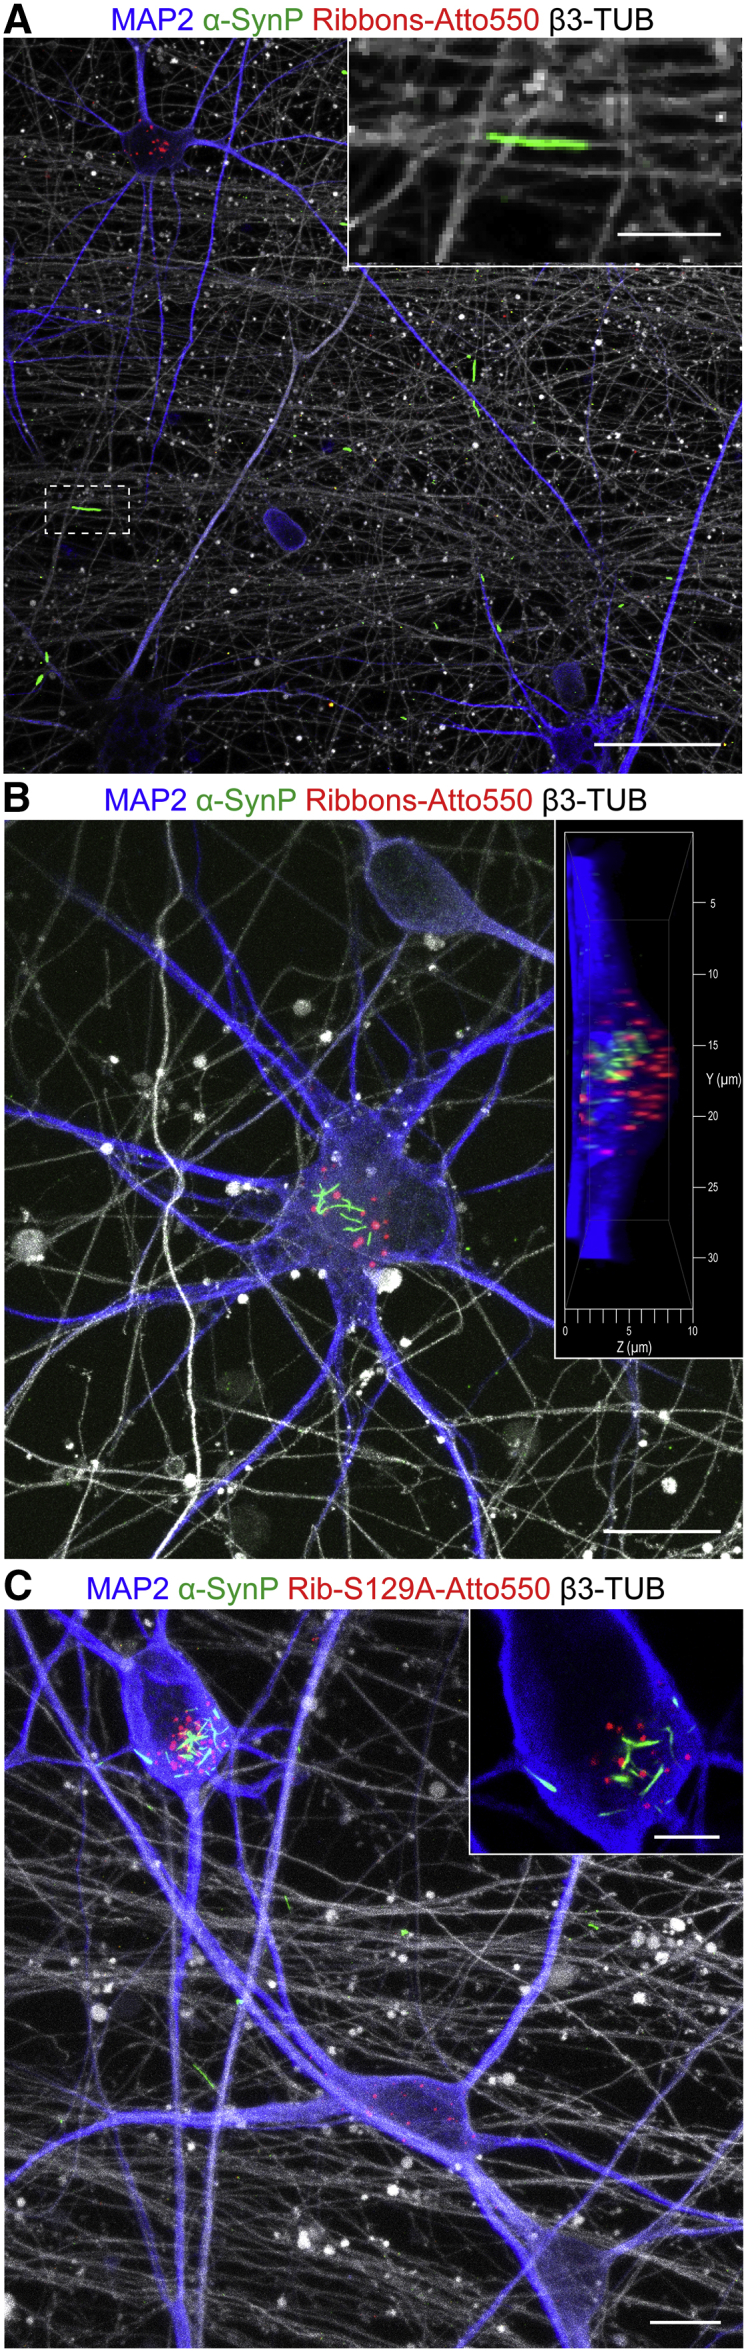
Induction of Trans-neuronal NucleationFluorescence confocal imaging illustrating endogenous α-SynP (green) in the distal chamber upon seeding of proximal neurons with exogenous α-Syn ribbons (made of WT in A and B, S129A α-Syn in C, red). Axons deriving from proximal neurons are identified using β3-tubulin (β3-TUB, gray), while neurons residing in the distal chamber are identified by MAP2 staining (blue).(A) α-SynP filiform structures are present in proximal neurons axons at 15 dpe.(B and C) At 21 dpe, α-SynP-positive clusters are detected as well in the cytoplasm of sparse distal neurons. Insets in (A) and (C) are enlargements of specific regions (highlighted with dotted lines if needed). Inset in (B) represents 3D reconstruction and orthogonal view of the intra-cellular α-SynP structures (Airyscan super resolution). Inset in (C) represents a single plane of the α-SynP cell.Scale bars: 40 μm in (A), 10 μm in (B) and inset in (A), 20 μm in (C), 5 μm in inset in (C).